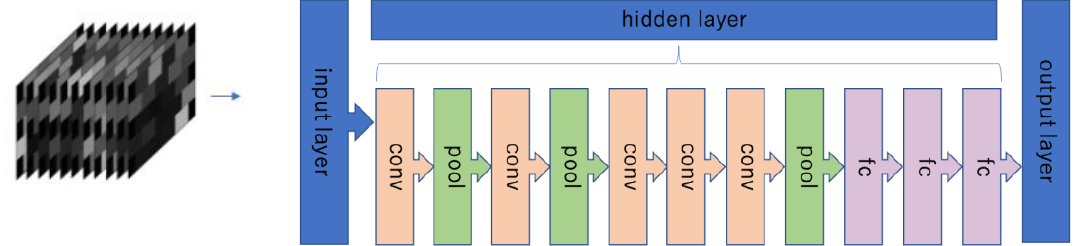
Figure 4. Structure of neural network (AlexNet). The input layer is that of the created image (input data were imaged from the data obtained at a sampling time of 10 Hz by fNIRS); the convolutional layers (conv) are layers that extract image features through a kernel; the max pooling layer (pool) is a layer that emphasizes features by reducing image size; the fully connected layer (fc) is a layer that merges the output from the pooling layer and sends it to the output layer.